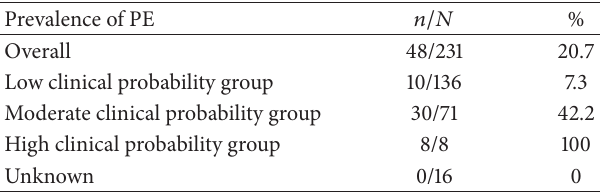
Table 4: Probability groups and prevalence of PE.